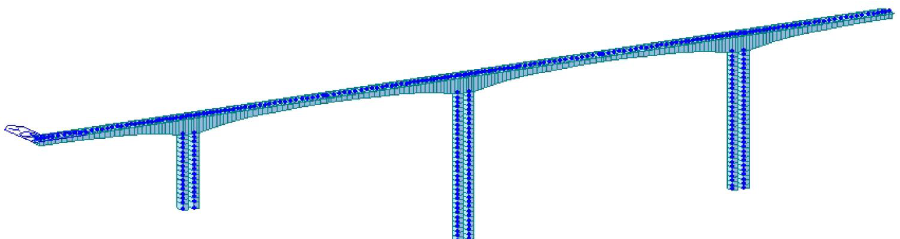
Figure 4. Finite element model of Xushuihe bridge.